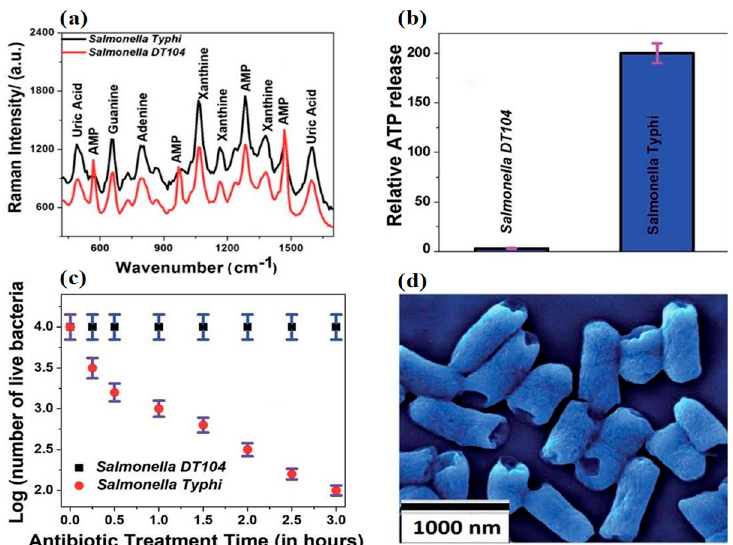
Figure 5. The Raman spectra of MDR Salmonella DT104 and a susceptible strain of Salmonella Typhi ( a ) on the heterostructure surface. Plots indicating the percentages of live bacteria for Salmonella DT104 and Salmonella Typhi after treatment with the ( b ) Augmentin antibiotic at 1000 CFU/mL. Plots showing the relative cellular ATP leakage from Salmonella DT104 and Salmonella Typhi after treatment with the Augmentin ( c ) antibiotic. An SEM image showing the damaged walls of Salmonella Typhi ( d ) after treatment with the Augmentin antibiotic. Figure modified with permission from [87]. (Copyright 2020, American Chemical Society).